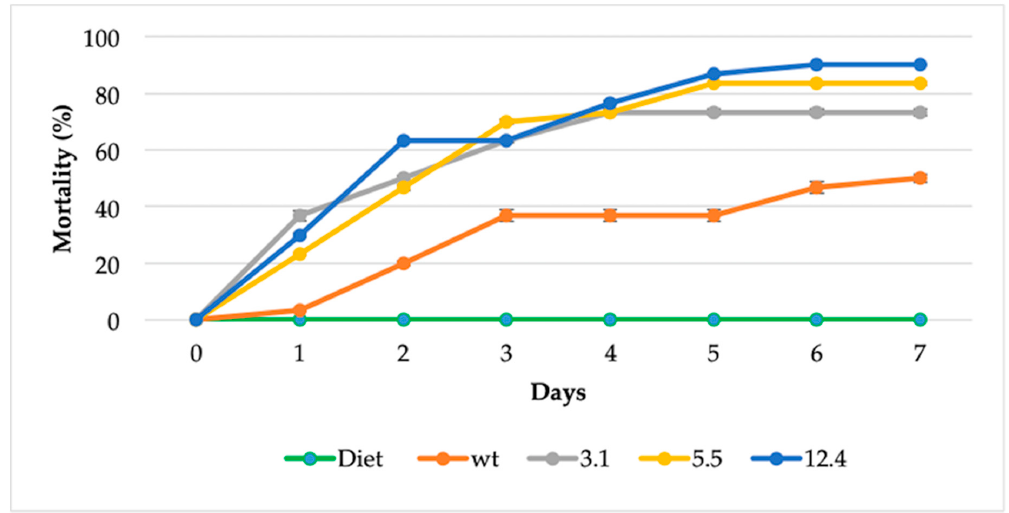
Figure 7. Toxicity of transgenic plants to S. frugiperda larvae on a plant-feeding assay. The data shown represent the mean of three independent experiments, and error bars indicate standard deviation of means (SD). Each experimental group was composed of 10 larvae and larvae mortality is reported as a percentage of the initial number of larvae. Diet is food for rearing S. frugiperda . The survival curve was significantly di ff erent from transgenic lines versus non-transformed plant (One way ANOVA, Tukey’s test, p <